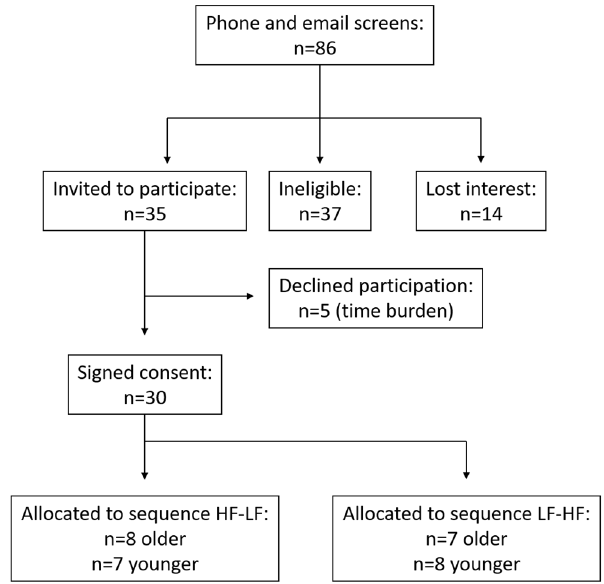
Figure 1. Participant eligibility, enrolment, and randomisation. HF, the high ‐ fat meal; LF, the low fat